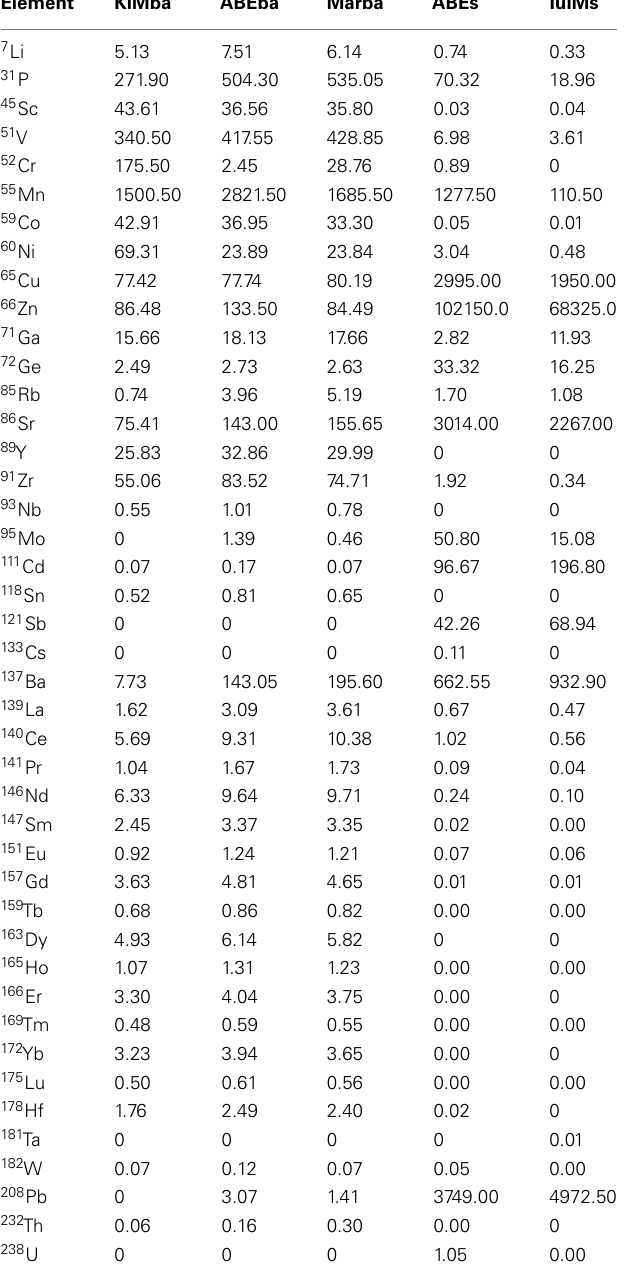
Table 3 |Trace element compositions of the rocks sampled.